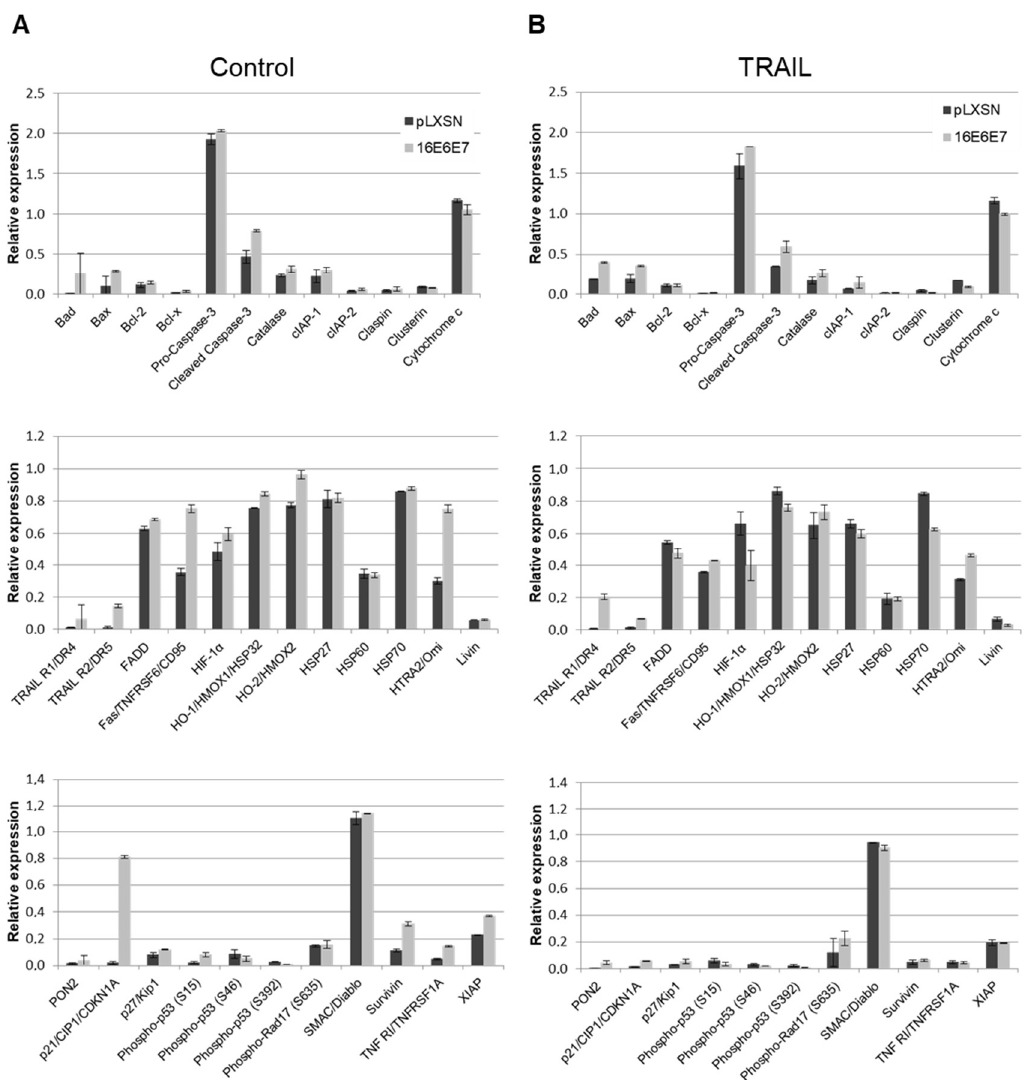
Figure 2. Effect of HPV16 E6 and E7 on the levels of proteins associated with apoptosis regulation/execution upon treatment with TRAIL. The expression of 35 proteins involved in the regulation/execution of apoptosis was determined in total protein extracts of epithelial organotypic cultures established from control (pLXSN) and HPV16 E6/E7 transduced PHKs before ( A ) and after ( B ) treatment with 25 ng/mL of TRAIL. For this purpose, we used the Proteome Profiler™ Array—Human Apoptosis Array Kit (R&D Systems, #ARY009), according to the manufacturer’s instructions. Signals obtained were quantified using ImageJ software and presented as expression relative to endogenous controls. The results presented are representative of three independent experiments.